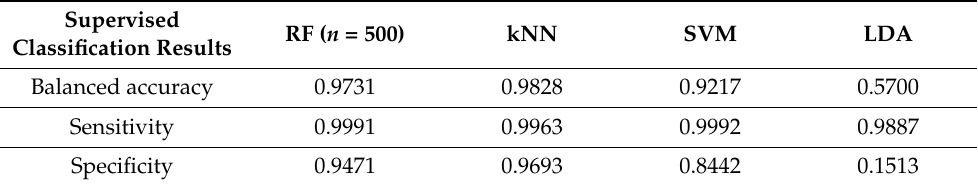
Table 2. Summary of the supervised classification results of the test set. 130 m / z values ( m / z range 600–2000) with 10-fold cross-validation. RF = random forest ( n = number of trees), kNN = k-nearest neighbors, SVM = support vector machine, LDA = linear discriminant analysis.